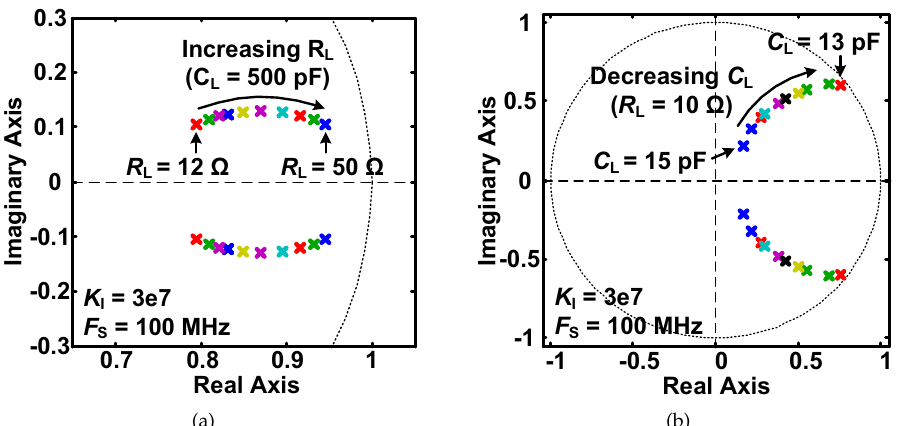
Figure 4. The pole plot of the proposed system under: ( a ) variable load resistance; and ( b ) variable load capacitance.